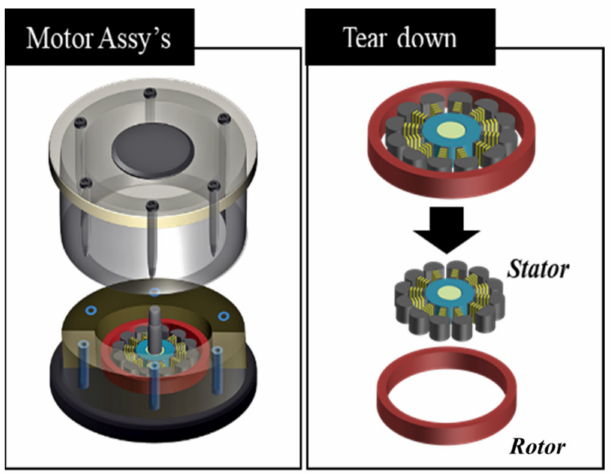
Figure 2. Schematics of motor assays and tear-down images of motor indicating stator and rotor (Nd 2 Fe 14 B bonded magnet).